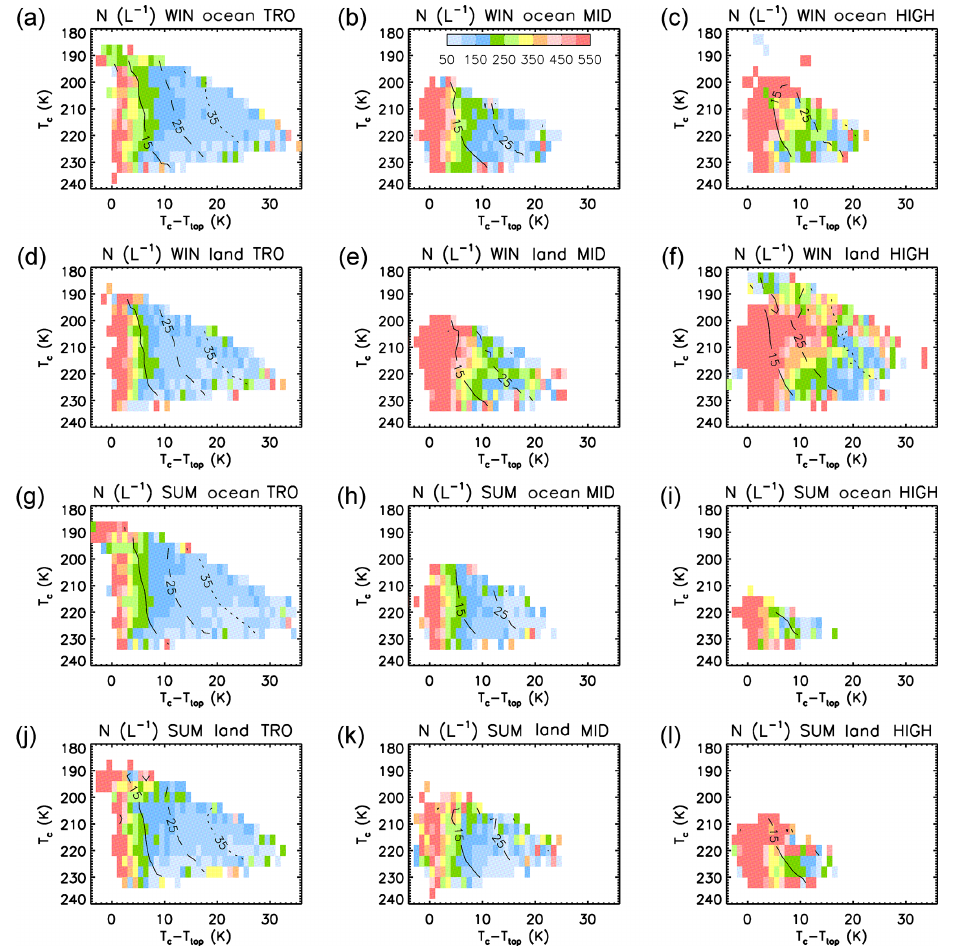
Figure 10. Median retrieved ice-particle number concentrations N (L − 1 ) using the SPARTICUS N(D) 1 unmodified formulation related to the representative cloud temperature T c and T c − T top at 0–30 ◦ (TRO, a, d, g, j ), 30–60 ◦ (MID, b, e, h, k ) and 60–82 ◦ (HIGH, c, f, i, l ) during 2008 and 2013. Overplotted are isolines of T base − T top (solid: 15K, dashed: 25K; dotted: 35K). Panels from top to bottom are for winter over oceans, winter over land, summer over oceans and summer over land. TRO, MID and HIGH refer to the tropics, mid- and high